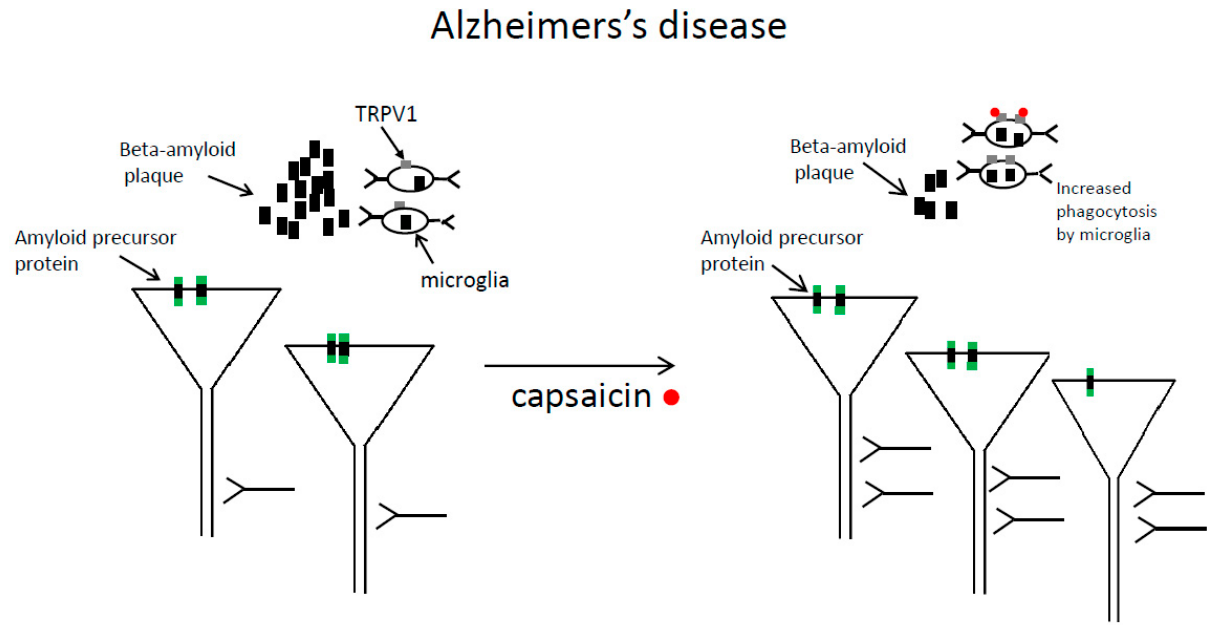
Figure 2. The beneficial effects of capsaicin in Alzheimer’s disease are shown in simplified form. Capsaicin treatment increases the number of cortical pyramidal neurons and reduces synapse loss. Additionally, capsaicin decreases beta-amyloid deposition in the extracellular space. One of the mechanisms is that capsaicin treatment enhances phagocytosis of beta-amyloid plaques by microglial cells (capsaicin binds TRPV1 receptors expressed on microglial cells). Left panel—before capsaicin treatment, right panel—after capsaicin